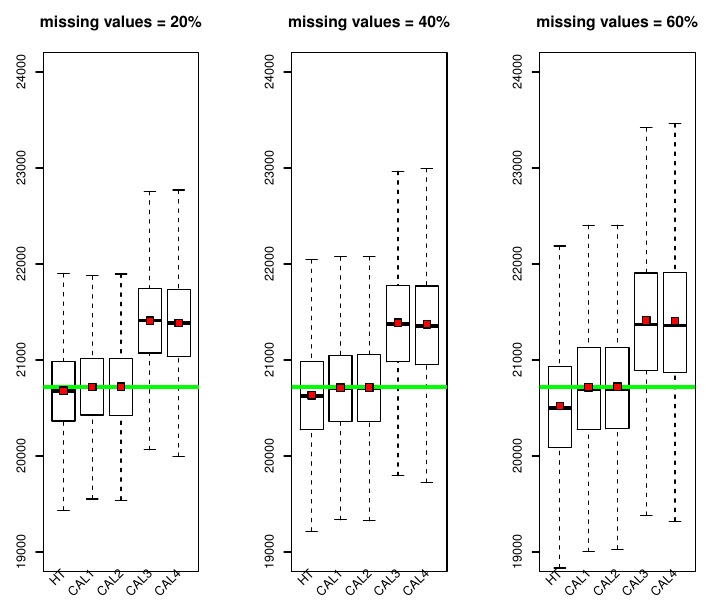
Figure 1. Missing at Random case. Boxplots of compared estimators for missing rates 20%, 40% and 60%. Green line is the true population mean. Blue square is the average over simulations runs.